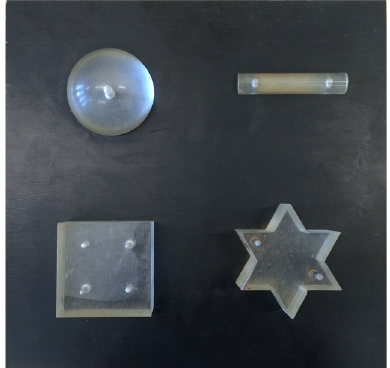
Figure 2. Void former with four acrylic blocks of varying geometry and dimension for artificial void formation. Table 2. Former shapes and